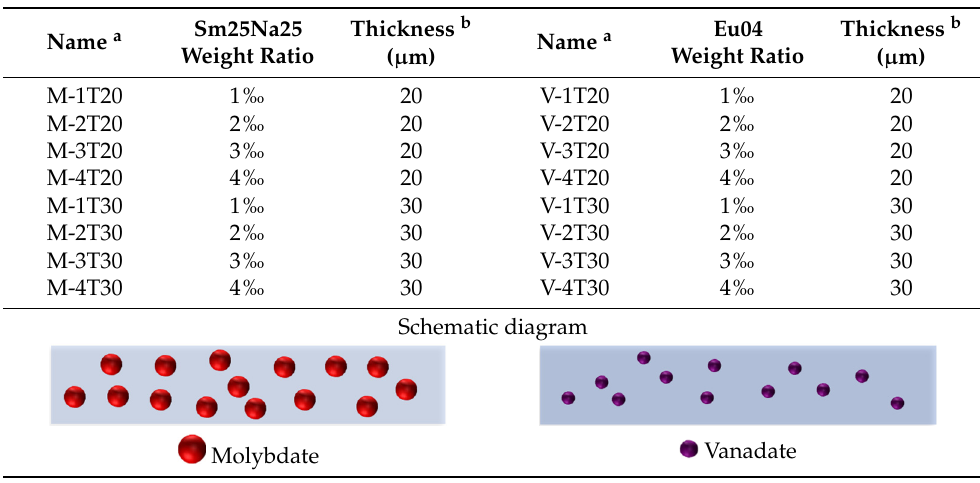
Table 3. The name of the polymeric luminescent coatings with single phosphors.